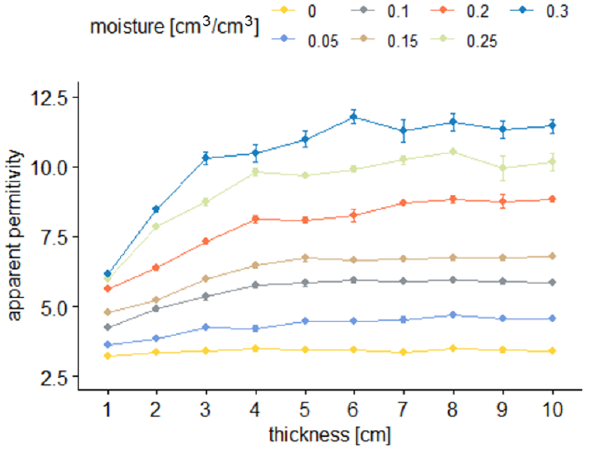
Figure 7. Average apparent permittivity readouts with sensor A depending on material moisture for particular sample thickness.